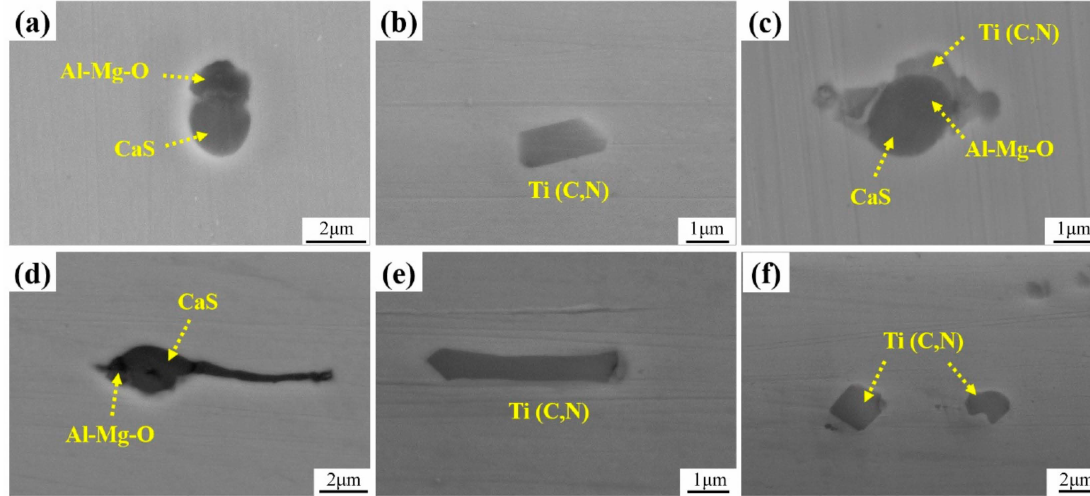
Figure 3. Scanning electron microscopy (SEM) morphology of inclusions in experimental materials: